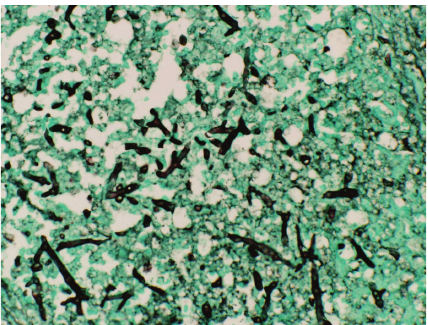
Figure 2: Operatively obtained jejunal tissue section from Patient 3 with fungal elements stained dark against green tissue background (Grocott-Gomori methenamine-silver stain, original magnification